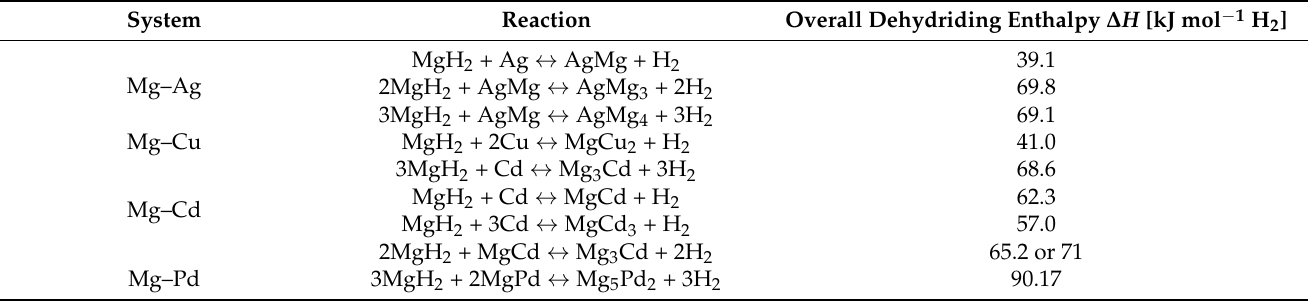
Table 2. Thermodynamic parameters of MgH 2 destabilized by different metals. Reprinted/adapted with permission from Ref. [127]. Copyright 2014, Elsevier.